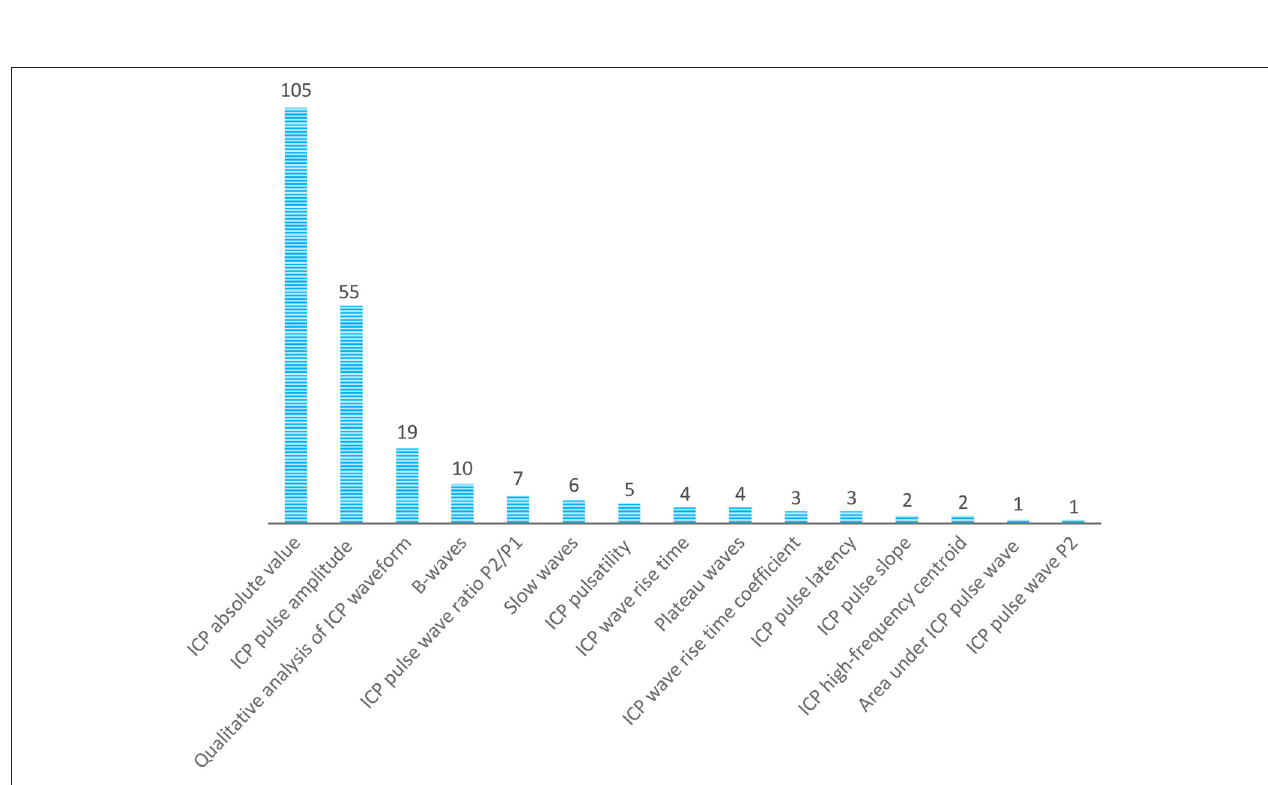
FIGURE 4 | Overview of the most assessed variables related to